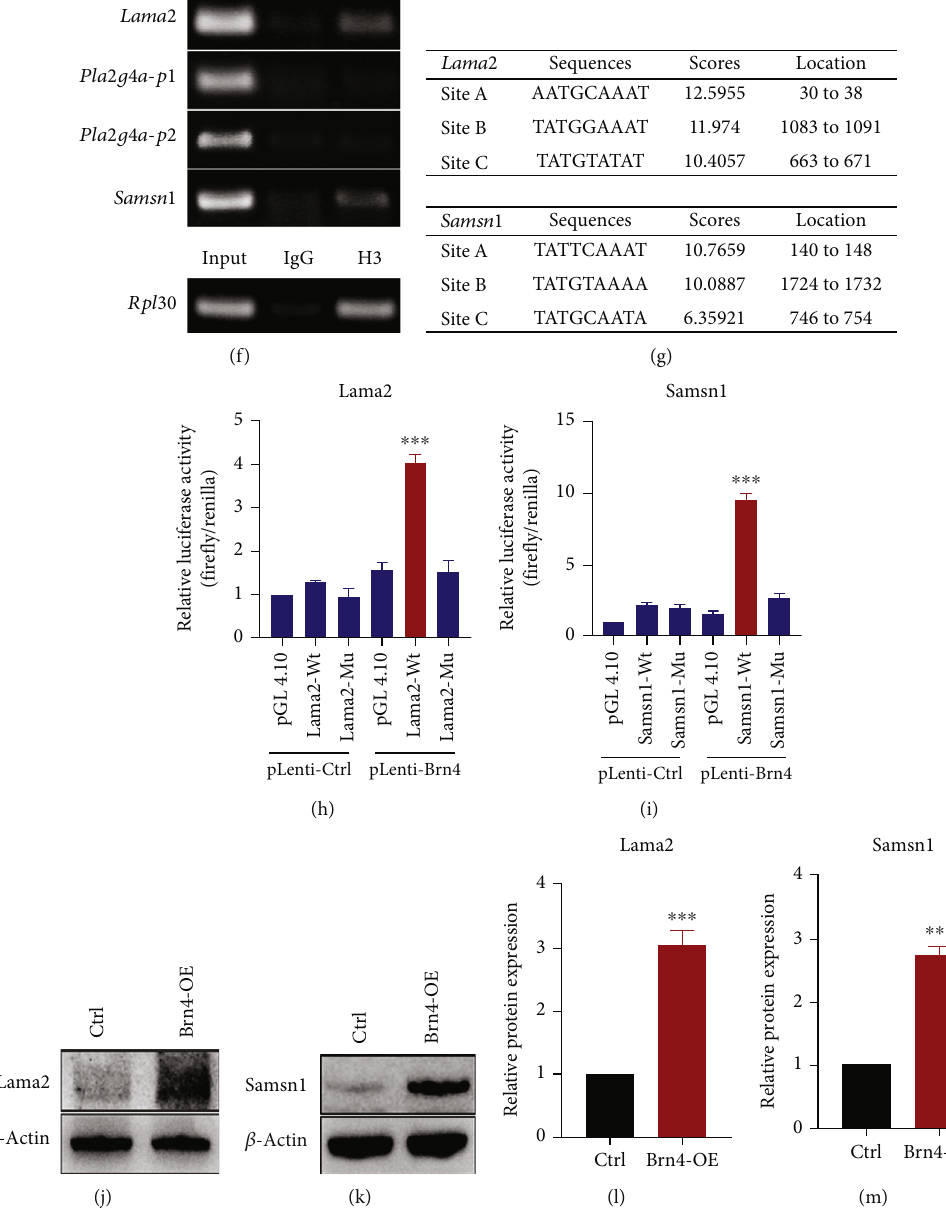
Figure 2: Brn4 binds to the promoters of Lama2 and Samsn1 and promotes their expression. (a) Overlapping genes of RNA-seq and ChIP- seq. (b, c) Representative immunoblots of Brn4-HA and β -actin in the N2a stable Brn4-overexpressed lentivirus strains (b) and quanti fi cation of Brn4-HA protein level normalized to β -actin (c). (d) Quanti fi cation of Brn4 mRNA level normalized to β -actin. (e) Quanti fi cation of mRNA levels for the overlapping genes between RNA-seq and ChIP-seq normalized to β -actin. (f) Nucleic acid electrophoresis for ChIP-PCR assay in the N2a stable Brn4-overexpressed lentivirus strains. (g) Sequences of the top three Brn4 binding sites on the Lama2 and Samsn1 promoters with the highest scores. (h, i) Dual-luciferase reporter gene experiment using N2a cells. (j – m) Representative immunoblots of Lama2, Samsn1, and β -actin in the N2a stable Brn4-overexpressed lentivirus strains (j, k) and quanti fi cation of Lama2 and Samsn1 protein levels normalized to β -actin (l, m). Error bars represent the mean ± SEM . n = 3 . ∗ P < 0 : 05 , ∗∗∗ P < 0 : 001 . Abbreviations: Ctrl: control; Brn4-OE: